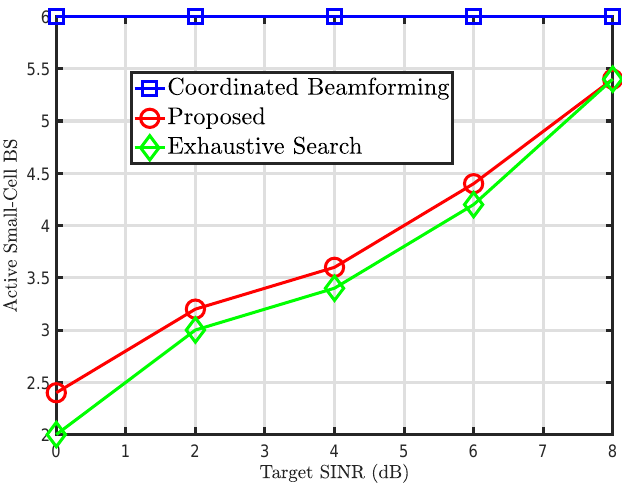
Figure 3. Number of active small-cell base stations (BSs) against target